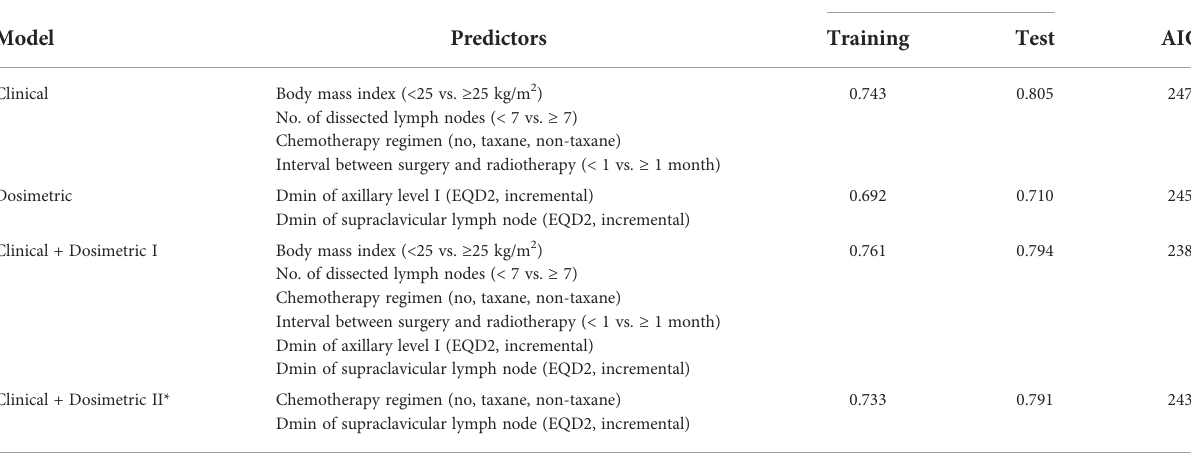
TABLE 3 Comparison of multivariable logistic regression models for prediction of lymphedema risk within 3 years after postoperative radiotherapy.